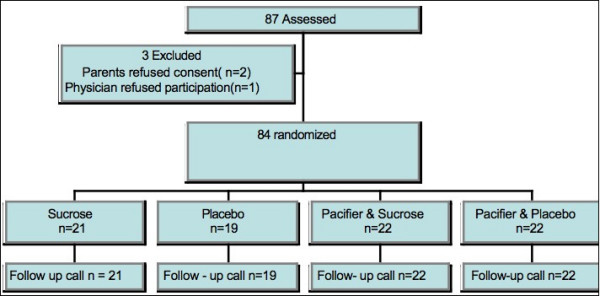
Study Flow Diagram.